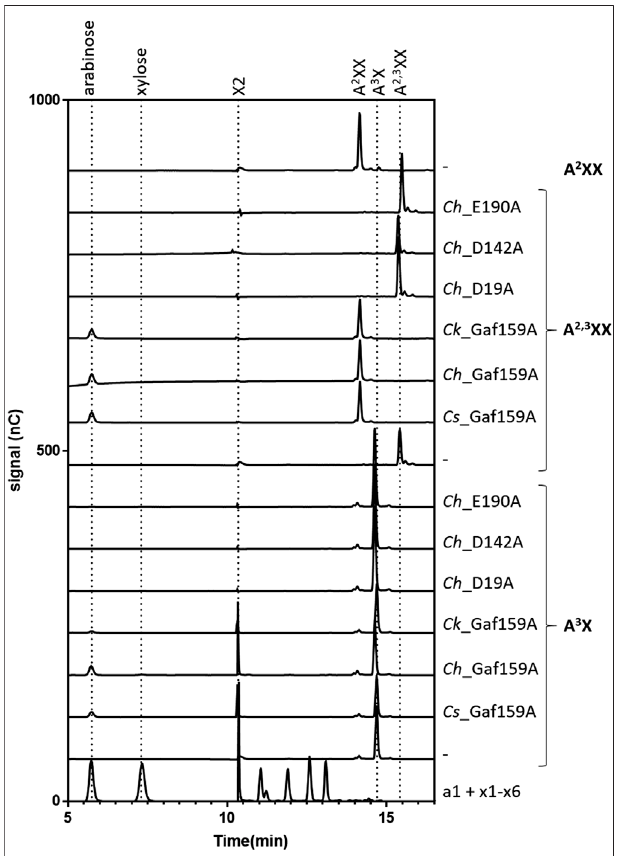
FIGURE 7 | Degradation of A 2,3 XX and A 3 X by Cs _Gaf159A, Ch _Gaf159A and Ck _Gaf159A but not by any of the Ch _Mutants.